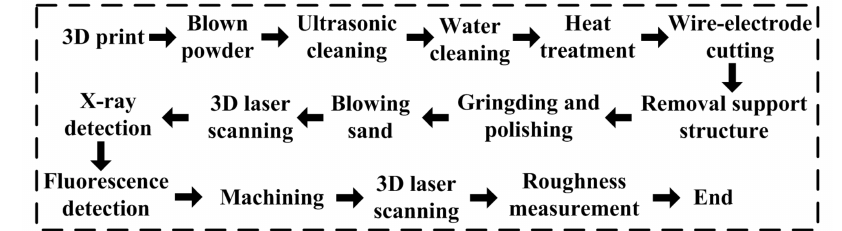
Figure 12. Post-processing steps for storage tank.